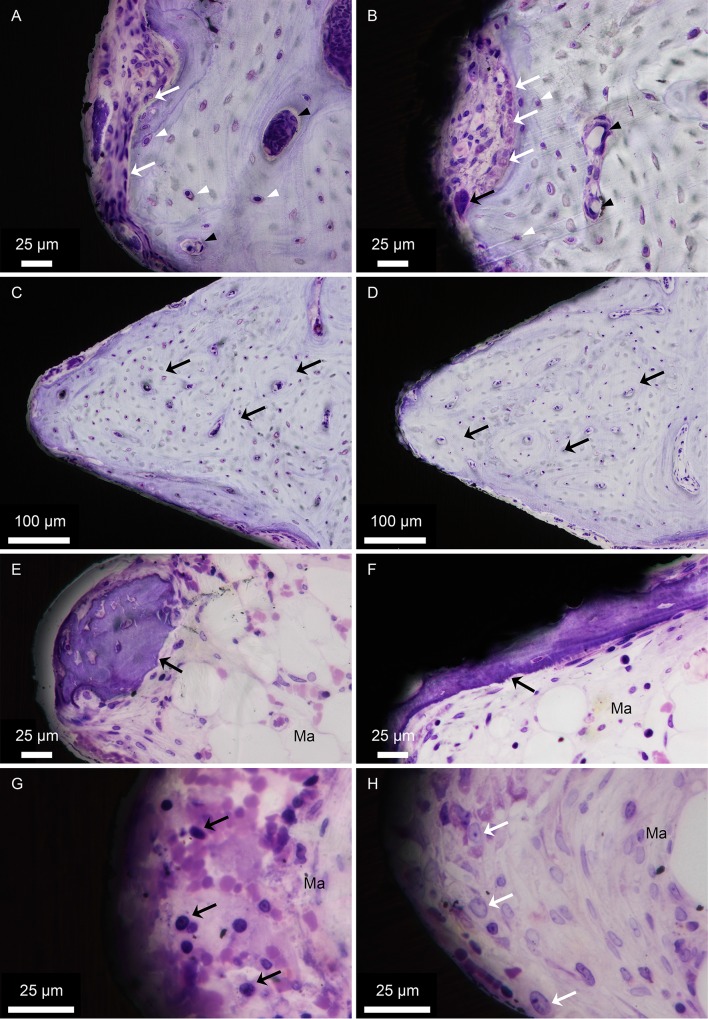
Histology.Undecalcified toluidine blue-stained sections of the (A, C, E, G) machined and (B, D, F, H) laser-modified implants. At the bone-implant interface, morphological features of bone formation and remodelling can be clearly observed in different threads in the cortical bone and the endosteal and bone marrow compartments. (A-B) Areas of ongoing remodelling. Osteoclasts (black arrows), osteoblasts (white arrows) and osteocytes (some of which are indicated by white arrowheads) are located in areas undergoing active remodelling at the interface. Blood vessels are indicated by black arrowheads. (C-D) For both implant types, mature bone occupies the endosteal threads, consisting of densely packed osteons (black arrows), with central blood vessels, surrounded by concentric bone lamellae and mature osteocytes. (E-F) Generally, the lower three threads of both implant types are occupied by bone marrow (Ma). Islands of newly formed, immature bone (black arrows) characterised by intense toluidine blue staining and large rounded osteocytes, which indicate an early stage of bone formation, are sometimes detected in the lower threads. This type of bone appears to be formed de novo and not as an extension from the endosteum. (G-H) Some of the bone marrow threads (Ma) show condensations of haematopoietic (black arrows) as well as relatively large and lightly stained mesenchymal-like cells (white arrows) adjacent to the implant surfaces.